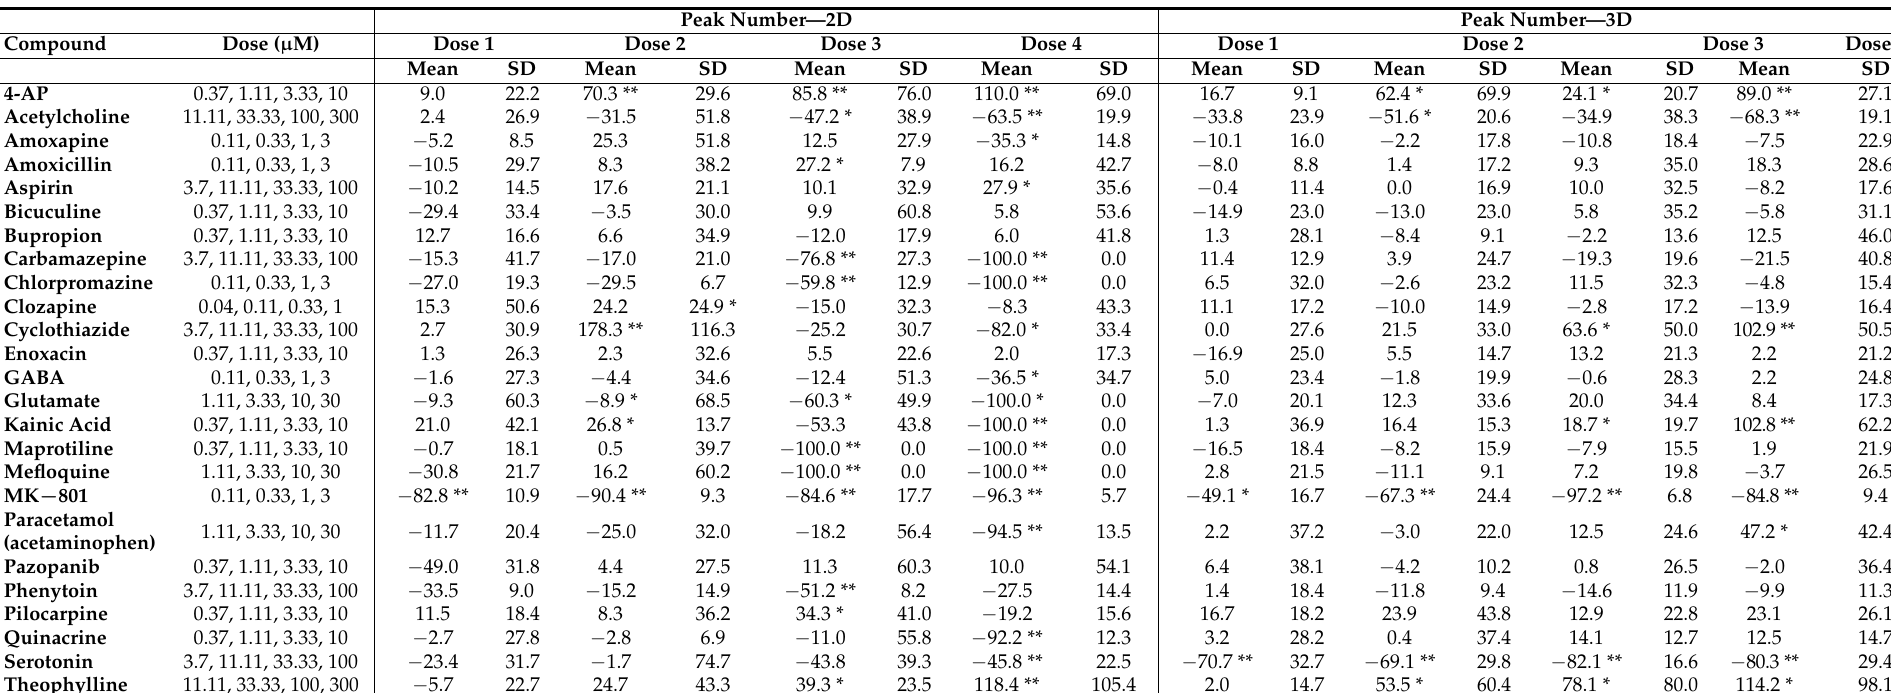
Table 3. Effects of 25 reference drugs in increasing concentrations on average and standard deviation of the effect of Ca 2+ peak number in hiPSC-derived neurons co-cultured with human primary astrocytes in 2D and 3D (expressed as % change from